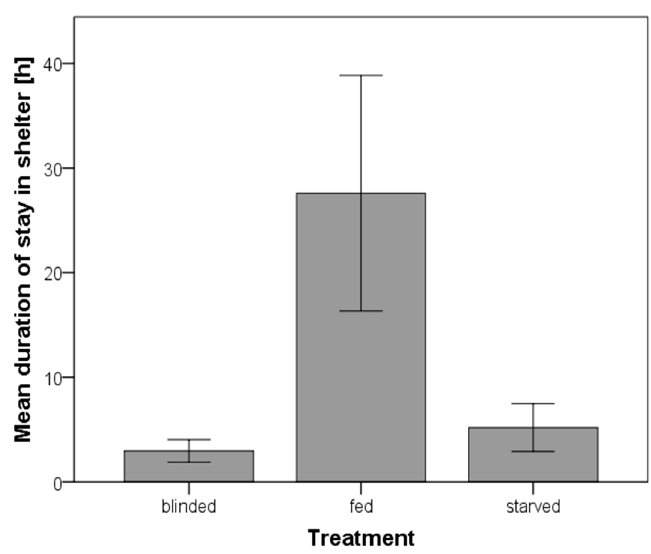
Figure 2. Mean duration of stay in a shelter of Acanthaster cf. solaris . Error bars represent the standard error.